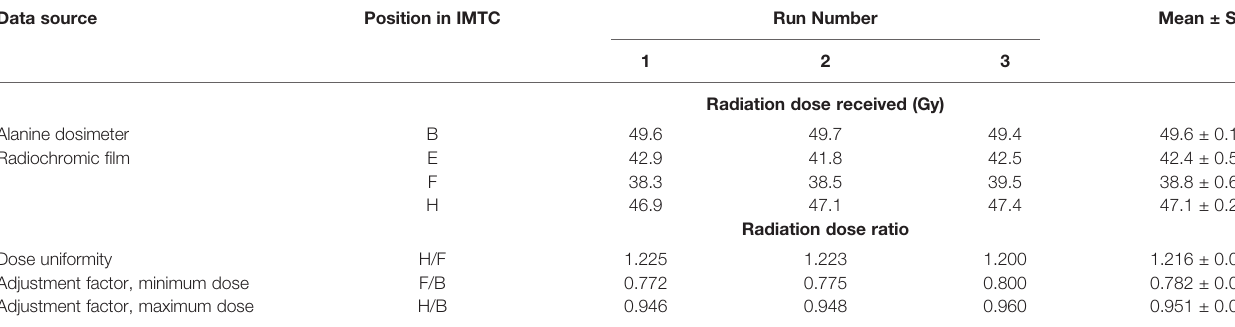
TABLE 1 | Radiation doses recorded in the ICs of the IMTCs in the radiochromic fi lm study in Figure 4 . Data source